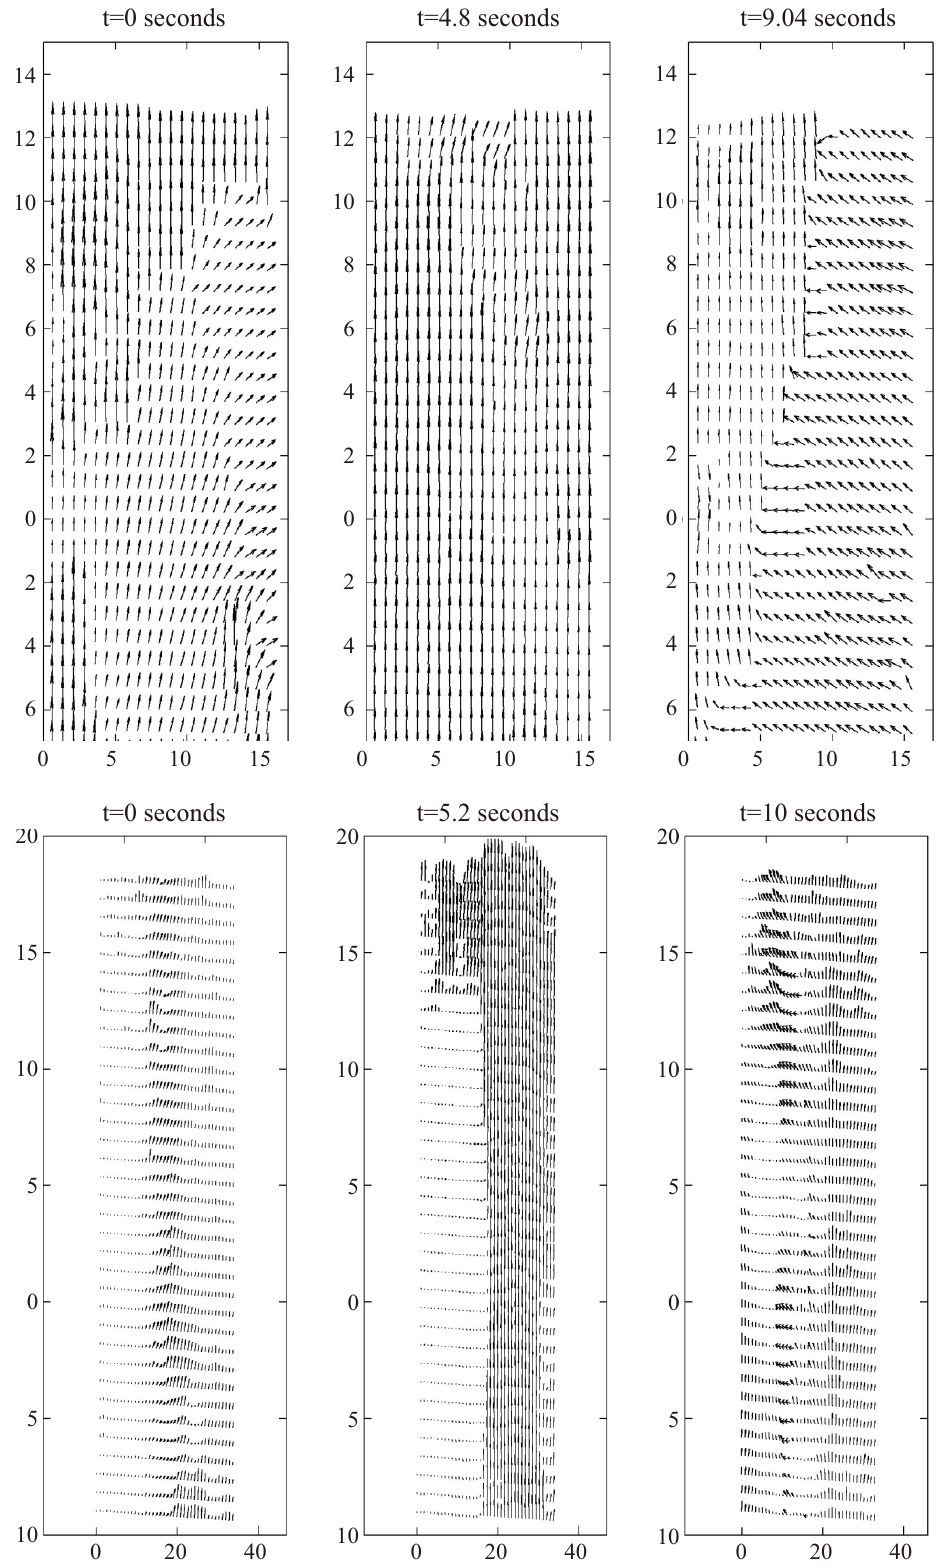
Fig. 14. Top view of horizontal velocity field at the “shallow” (upper) and “deep” (lower)